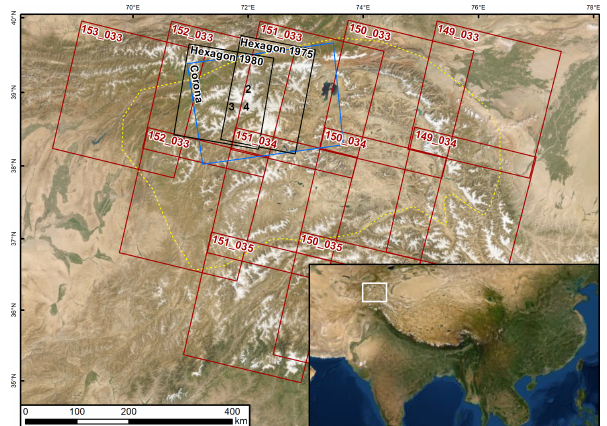
Figure 1. Location of the study region (white square in the inset) and footprints of the Corona (blue), Hexagon (black) and Landsat (red) scenes used in this study. The dashed yellow line marks the perimeter of the study region. The location of the subregions dis- played in Figs. 2, 3 and 4 are marked with their respective numbers. Image sources: screenshots from © Google